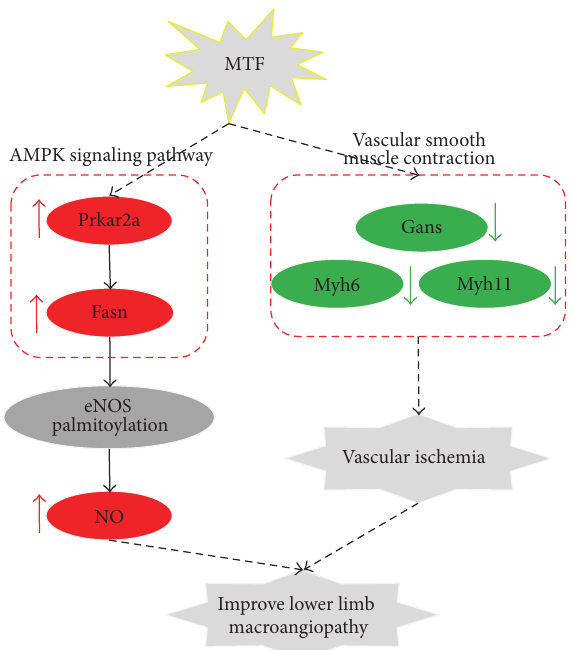
Figure 5: Mechanism of MTF treatment for lower limb macroan- giopathy in